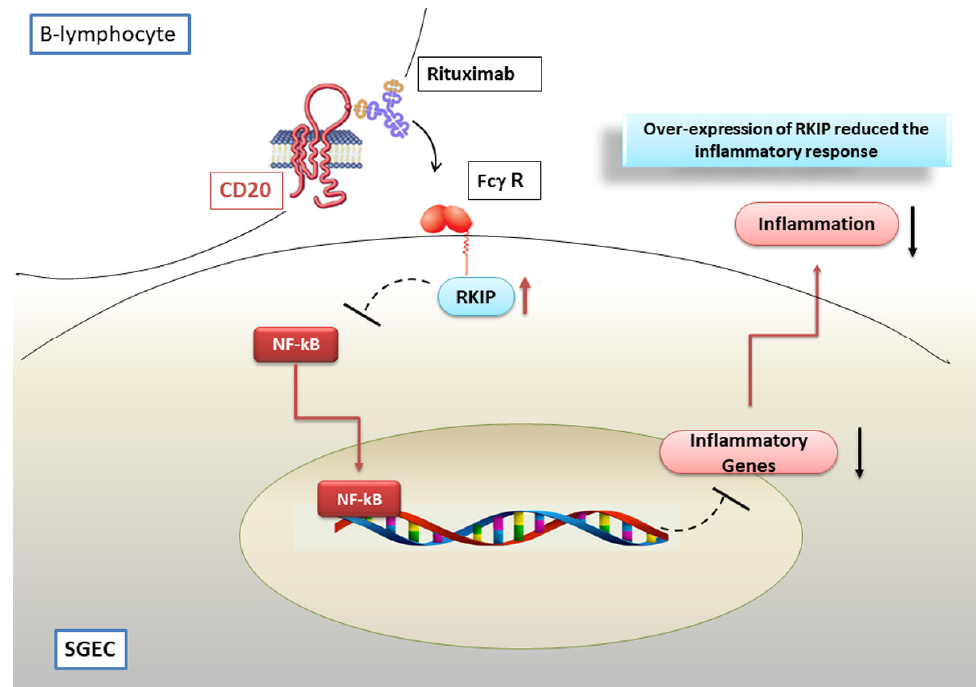
Figure 5. Rituximab (RTX) inhibits NF- κ B signalling in pSS SGEC. The pSS SGs epithelial cells (SGEC) were found to express low levels of Raf-1 kinase inhibitor protein (RKIP). In a co-culture system with pSS B-lymphocytes, the Fc γ R-mediated interaction of RTX / CD20 induces the upregulation of RKIP expression, decreasing NF- κ B activity, and, consequently, inhibiting the pro-inflammatory genes